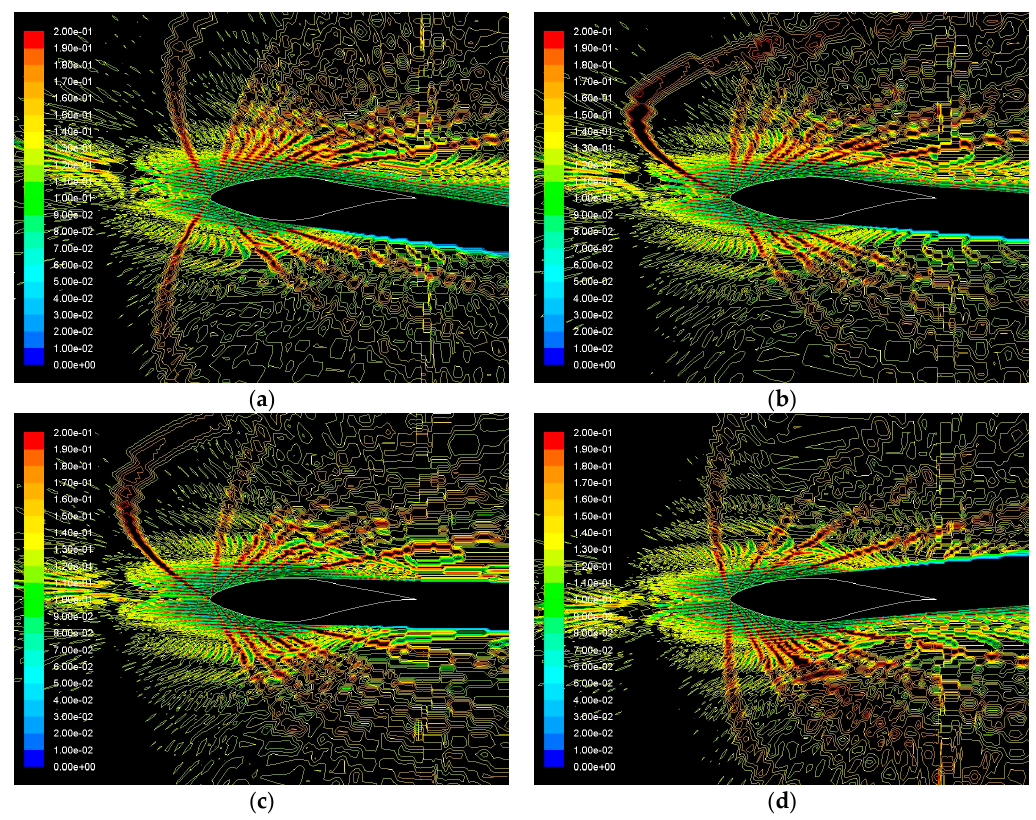
Figure 14. Contours of DPM concentration at ( a ) − 3°; ( b ) 0°; ( c ) 3°; and ( d ) 9° angles of attack at Re = 1 × 10 6 with the realizable k– ε turbulence model for an S809 airfoil for air-sand particle two-phase flow and 10% concentration of sand particles in the air.